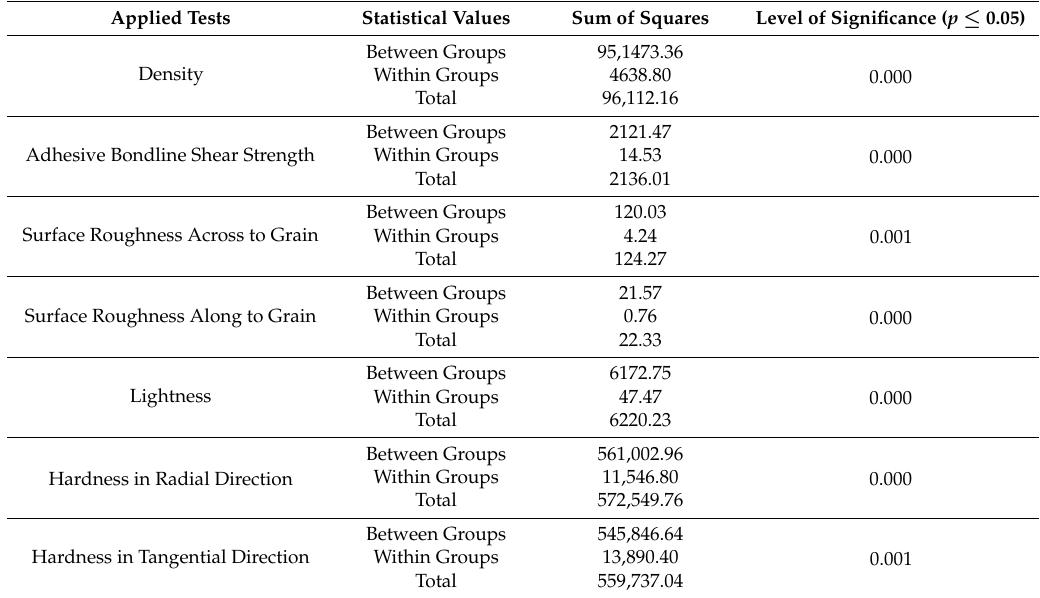
Table 3. Analysis of variance related to the effect of the temperature level on density.